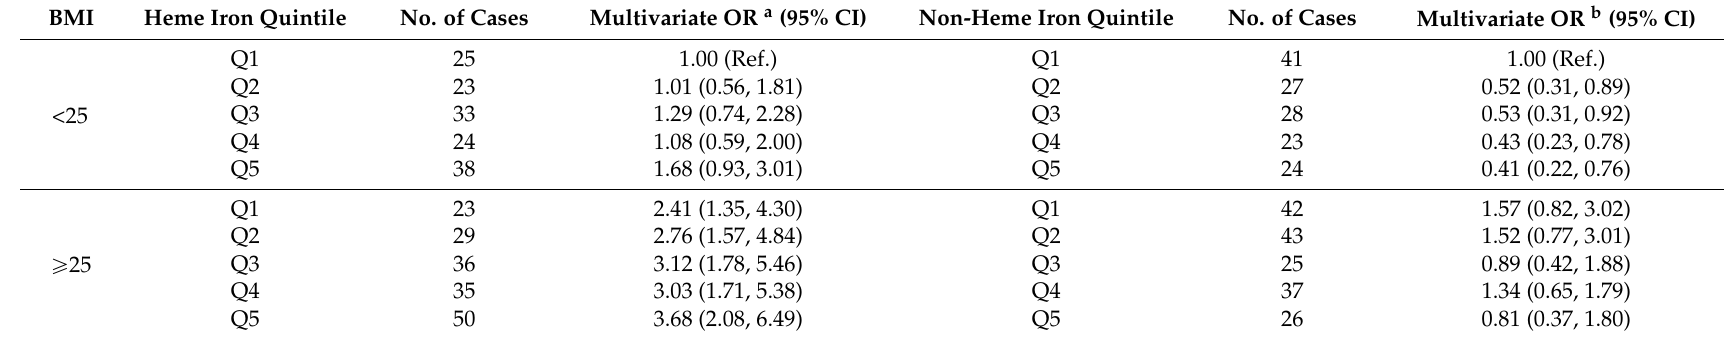
Table 3. Multivariate ORs for the joint association between iron intake, body mass index, and GDM ( n = 7229, cases =